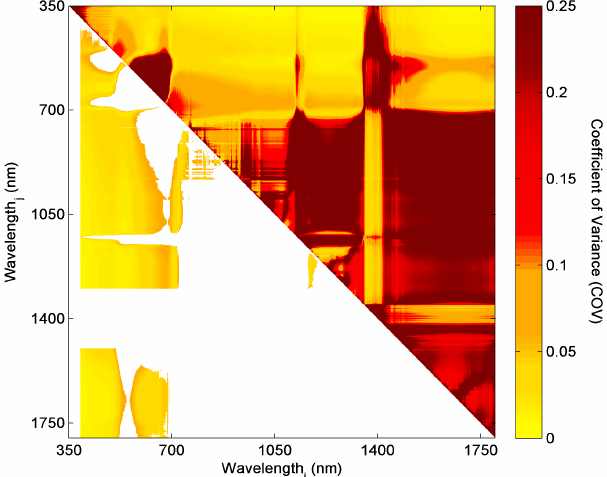
Figure 3. The coefficient of variation (COV), i.e. the ratio between daily standard deviation and the daily mean (measurements taken between 08:00 and 18:00 (UTC)), for different normalised differ- ence spectral index (NDSI) wavelength ( i,j ) combinations for 12 days at the peak of the growing season 2011 (day of year 237–251; n = 576). The COV indicates how strongly the NDSI are affected by variable sun angles. The upper right half of the chart shows the unfiltered R 2 values, whereas the lower left half shows filtered R 2 , based on the filtering criteria described in Sect.